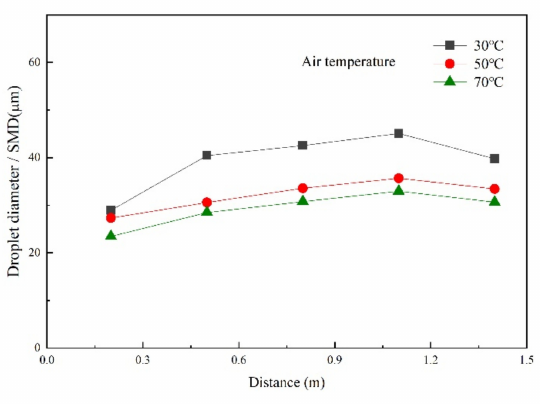
Figure 9. The droplet particle size with different air